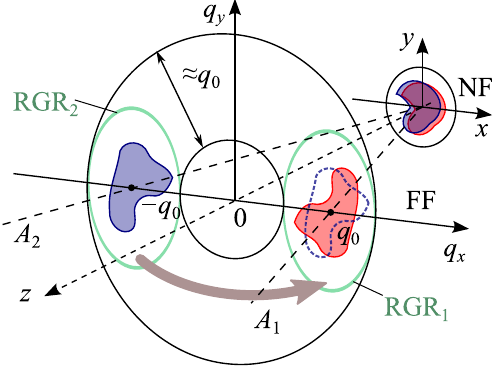
FIG. 4. Geometry of the localized squeezing preparation. A 4WM gain medium in the near field (NF) produces local quantum correlations between the Ω and the − Ω sidebands. As a result, overlapped modes fulfilling the phase conjugation relation are correlated (twin mode 1 and twin mode 2, represented as overlapped colored regions in the near field). After propagation to the far field (FF), those correlated modes are contained in an annulus-shaped region resulting from the phase-matching con- dition. On this diagram, we only represent the positive- q part of x twin mode 1 and the correlated negative- q part of twin mode 2. x These correlated modes follow the z -axial symmetry imposed by the phase-matching condition, and we further assume that they are contained in RGRs that are on the q axis. In order to create a x multi-spatial-mode squeezed field which is fully included in a RGR, i.e., in a simply connected gain region in the far field, one can superpose RGR 2 on RGR 1 on a 50 = 50 beam splitter (not shown on this diagram) and select A 1 as the new optical axis. This is equivalent to translating the spectrum of the field in RGR 2 by q 0 and the spectrum of the field in RGR 1 by − q 0 along q x